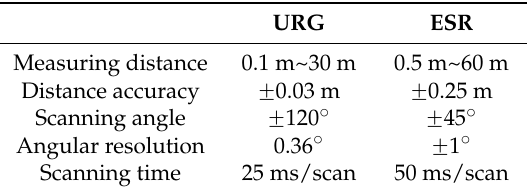
Table 2. Parameters of URG and ESR.